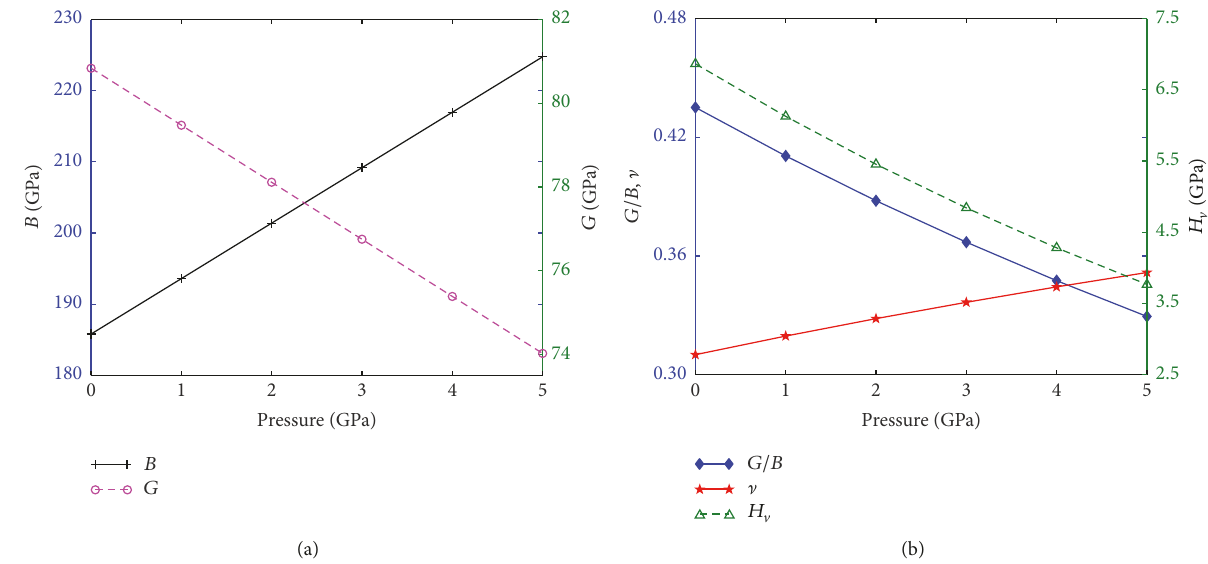
Figure 5: The pressure dependence of (a) 𝐵 and 𝐺 and (b) 𝐺/𝐵 , ] , and 𝐻 V